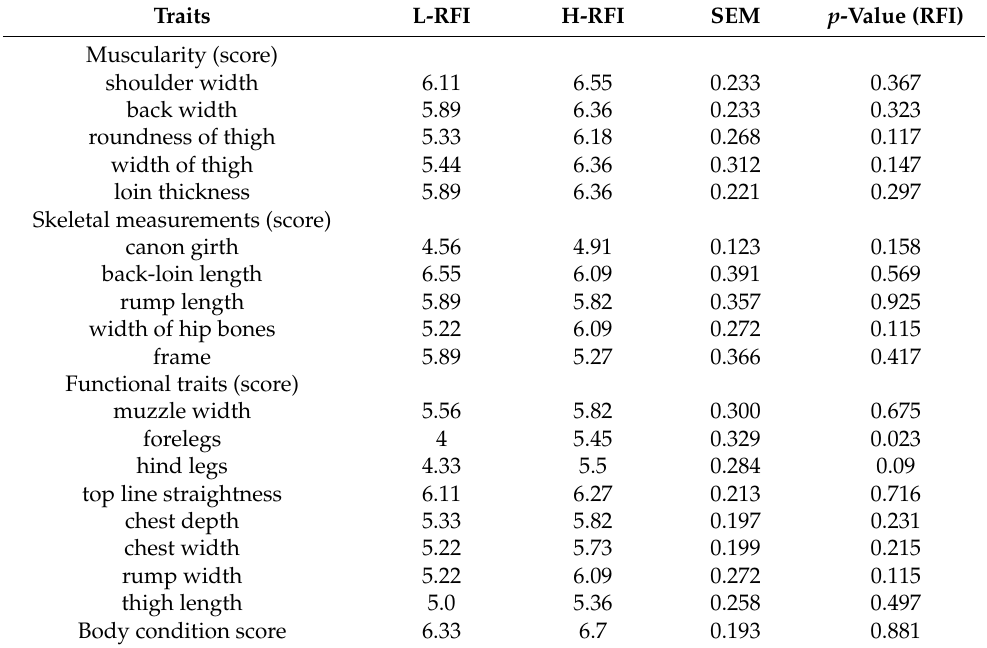
Table 3. Judgement of animals with low (L-RFI) and high RFI (H-RFI). RFI: residual feed intake. Traits L-RFI H-RFI SEM p -Value (RFI)